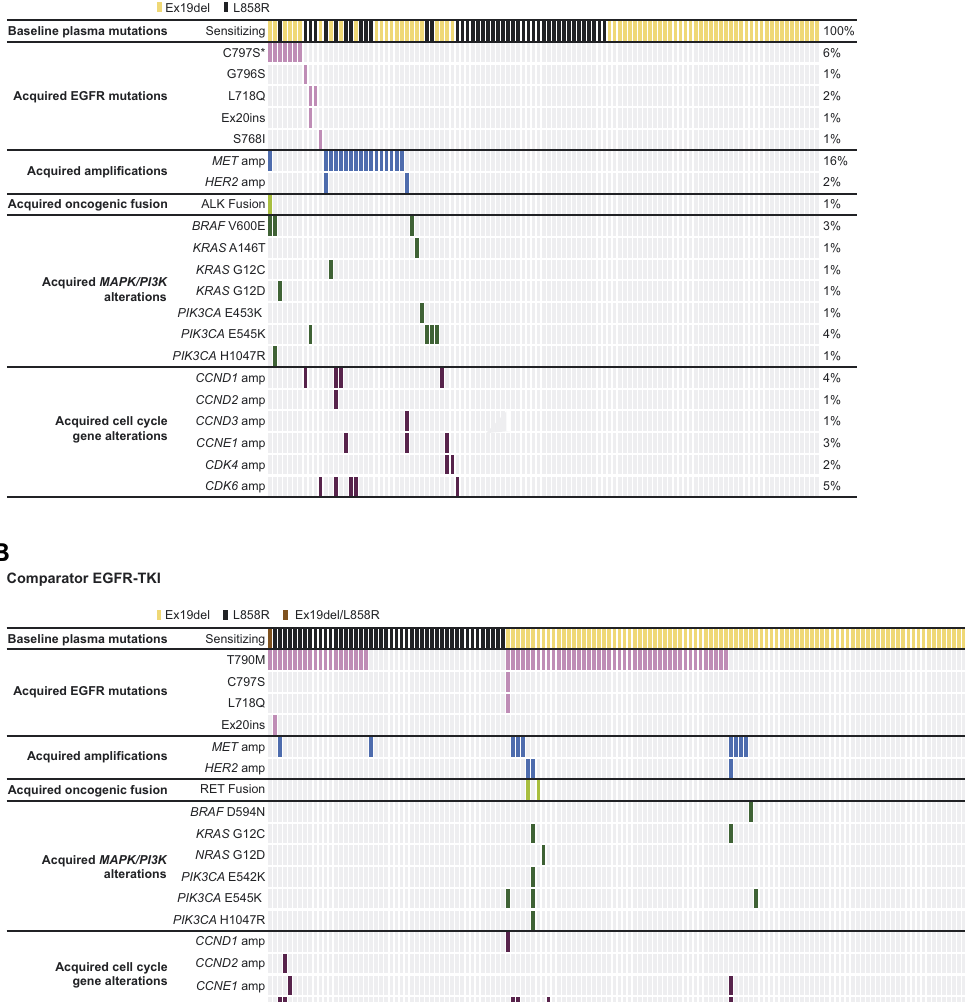
comparatorEGFRI-TKIs( n =145)fromtheFLAURAtrial.Sourcedataareprovidedin the Supplementary Data 1 fi le. *One patient had co-occurring C797S and C797N. EGFR epidermal growth factor